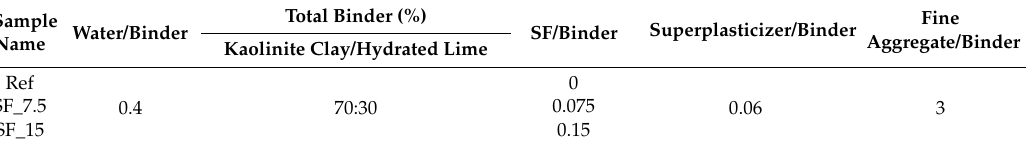
Table 2. Mix proportions of kaolinite clay based mortar (by weight ratio of